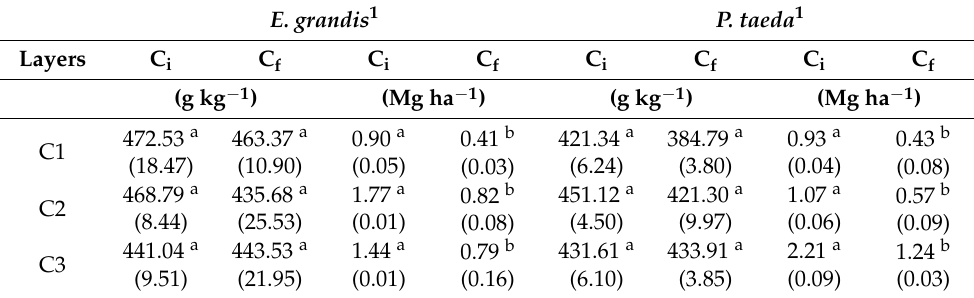
Table 6. Concentration and initial and final carbon stock (C i and C f ) for the analyzed litter layers of E. grandis and P. taeda